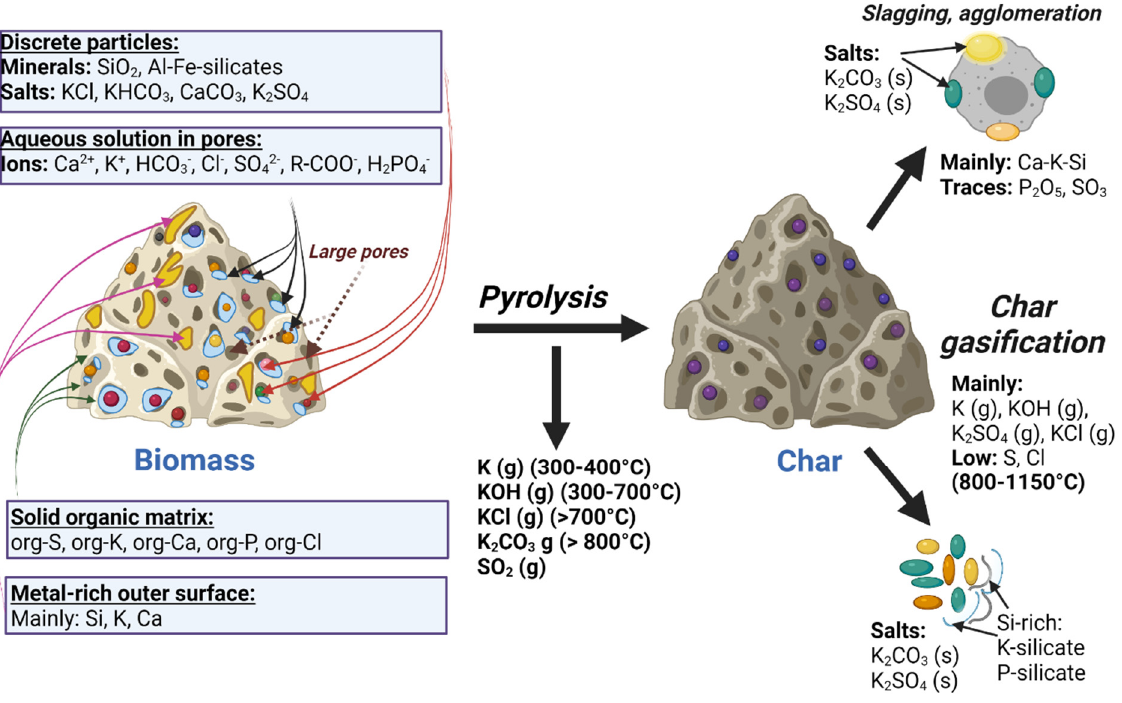
Figure 5. Inorganic transformation mechanisms and structural changes in feedstock during char formation and gasification [14,76,80]. Table 3. Experimental studies investigating the effects of inherent inorganic content on the gasifica- tion of char.